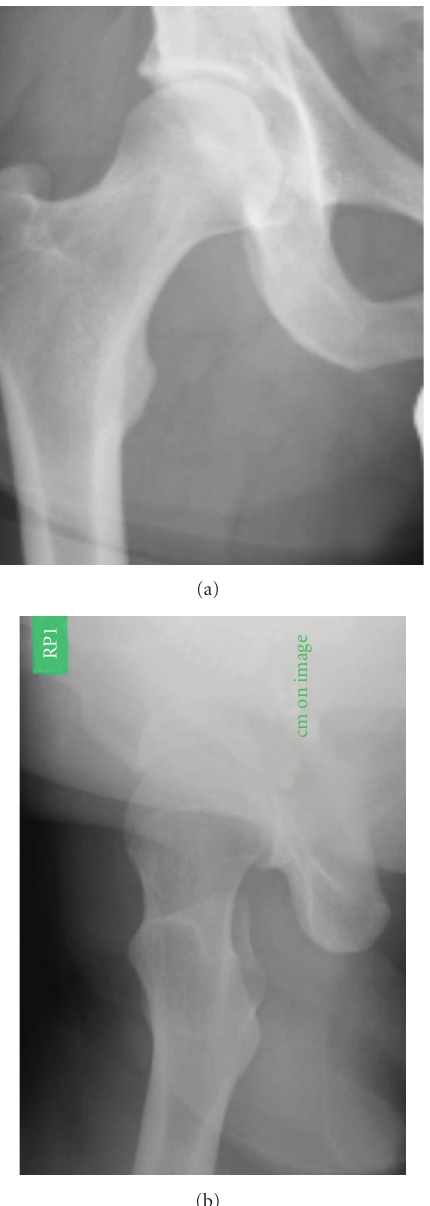
Figure 4: a/p view of the X-ray (a) and lateral view (b) of the right hip 6 months after closed reduction shows a congruent hip joint and no signs of AVN or